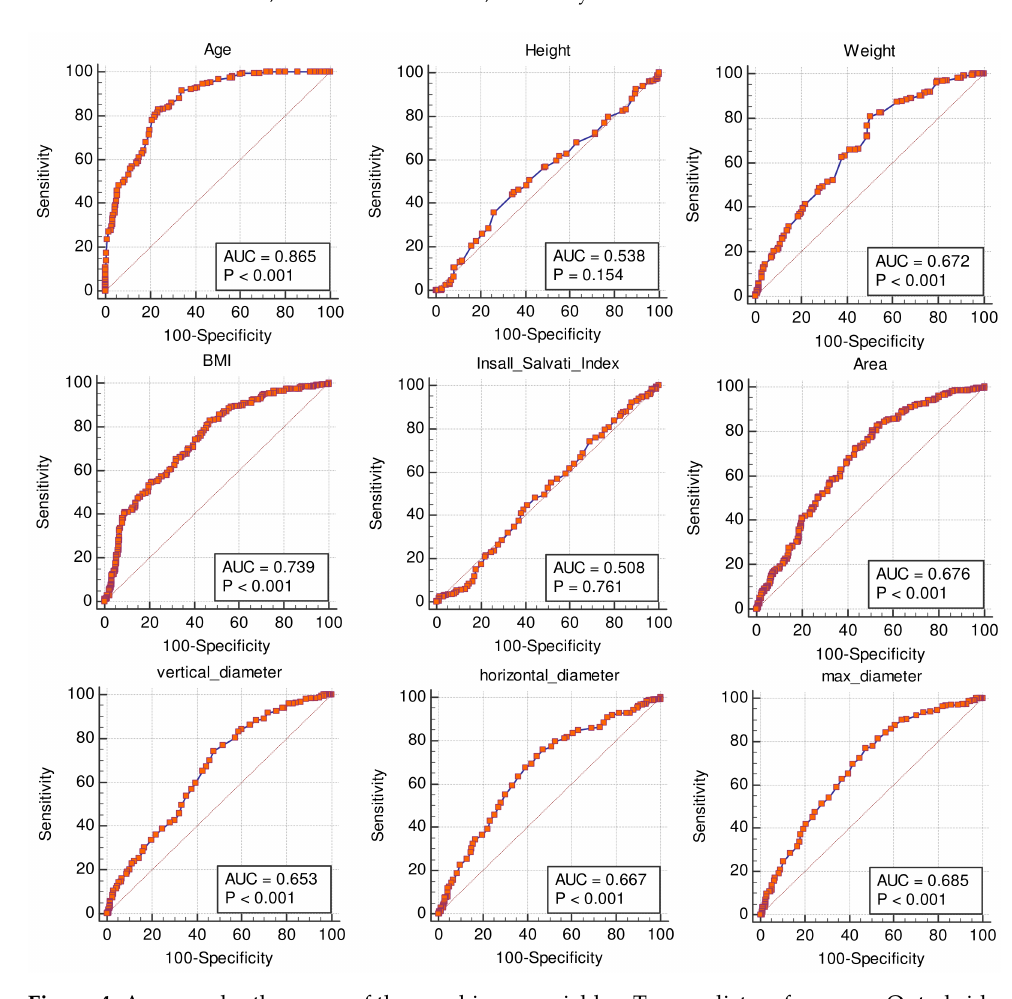
Figure 4. Areas under the curve of the non-binary variables. Top predictors for severe Outerbridge score before normalization are age, BMI and maximal knee